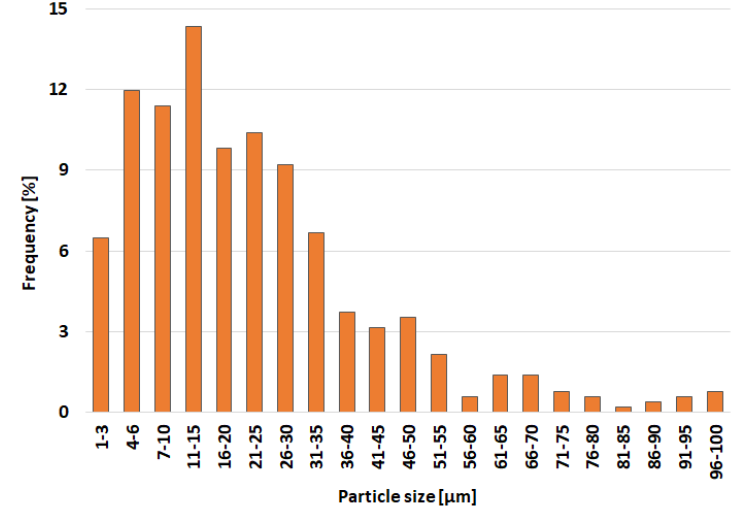
Figure 2. Distribution of particle size of initial Ti-25Nb-4Ta-8Sn powder.